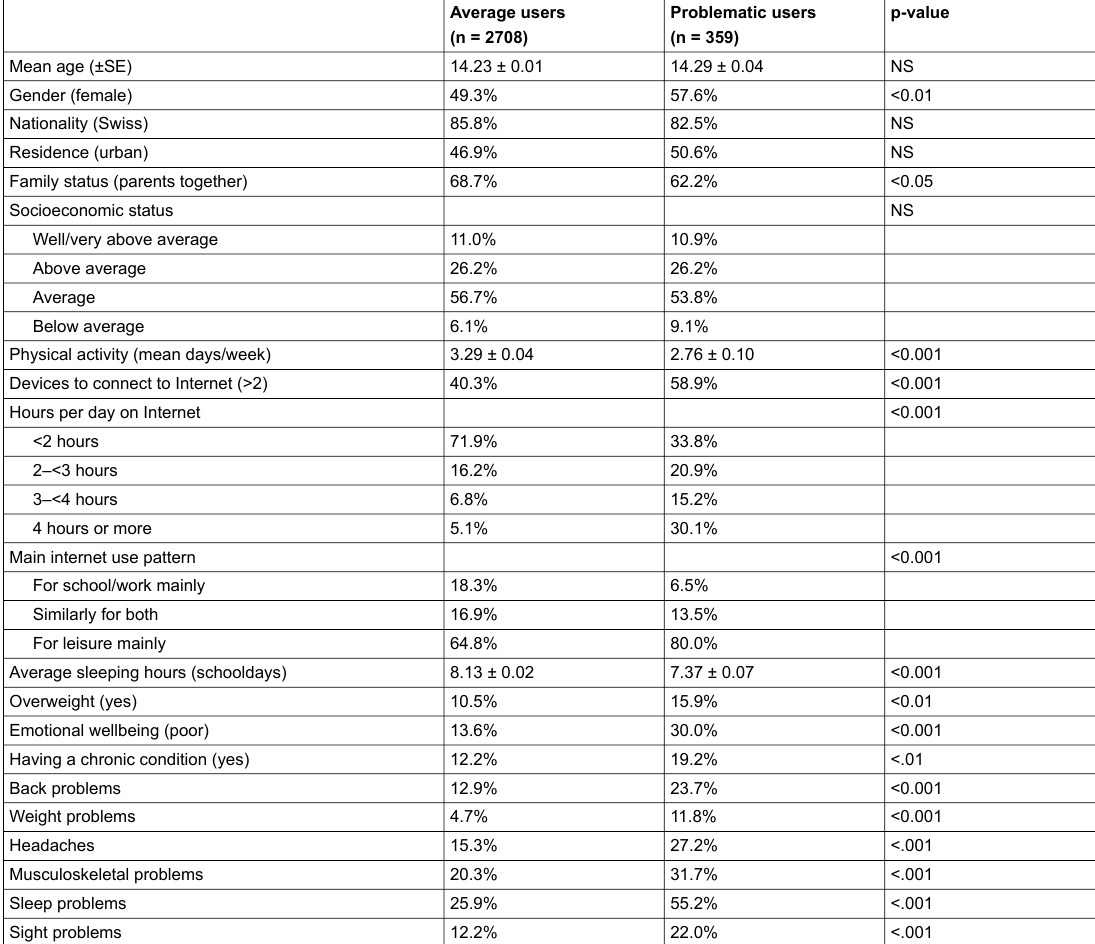
Table 1: Bivariate analysis comparing average and problematic internet